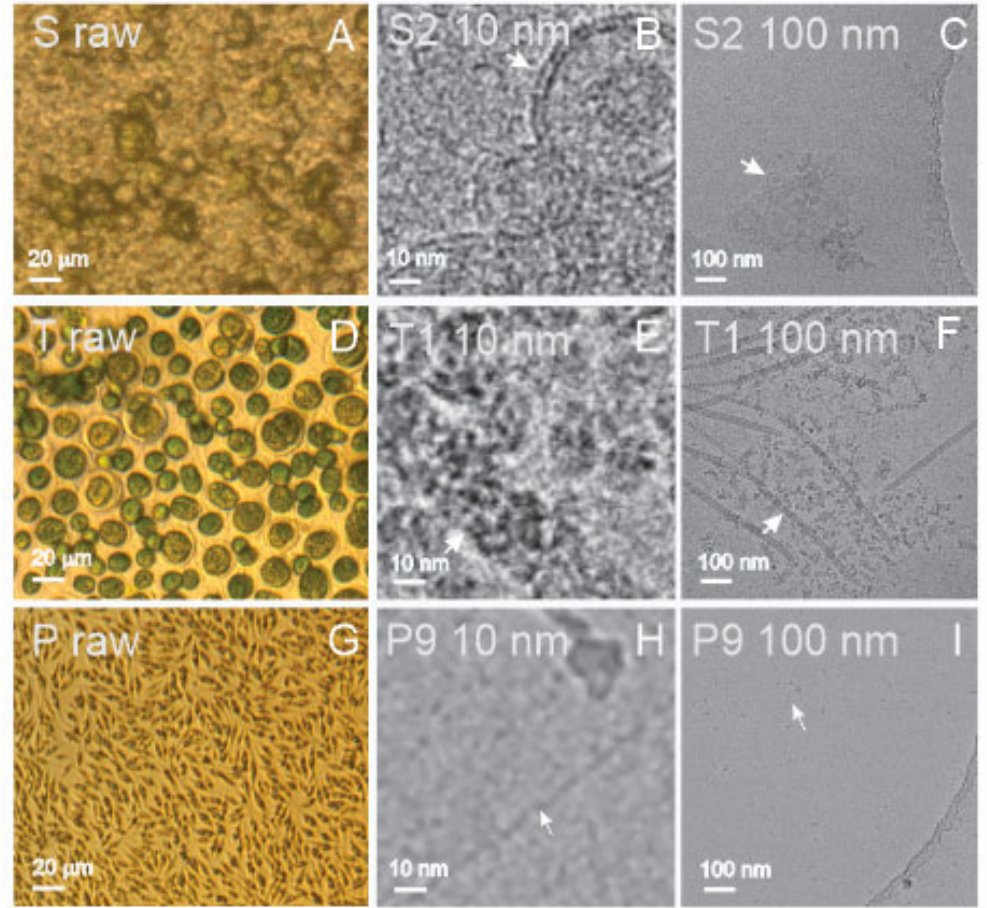
Figure 2. Visualization of samples derived from spruce needle homogenate and microalgae-conditioned media. ( A ): spruce needle homogenate, ( B , C ): isolate from spruce needle homogenate, ( D ): culture of Tetraselmis chuii microalgae, ( E , F ): isolate from Tetraselmis chuii conditioned media, ( G ) microalgae Phaeodactylum tricornutum culture:, ( H , I ): Phaeodactylum tricornutum isolate from conditioned media . ( A , D , G ): light microscopy; ( B , C , E , F,H,I ): cryo ‐ TEM microscopy. White arrows in panels ( B , C ), ( E , F ), and ( H , I ) point to the same spots, respectively. Labels in the upper left corner correspond to labels in the raw data (DOI: 10.5281/zenodo.7178202).